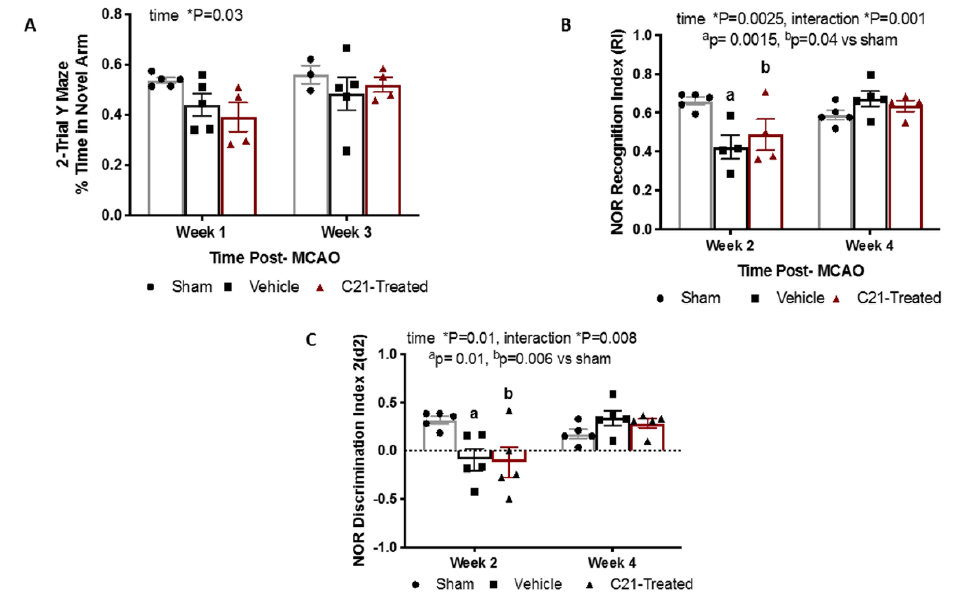
Figure 6. C21 did not impact cognition in female rats. ( A ) C21 did not affect spatial memory as assessed by 2 trial Y-maze. ( B ) C21 did not affect recognition memory as assessed by novel object recognition (NOR) testing. ( C ) No differences were observed among groups. One-way ANOVA.